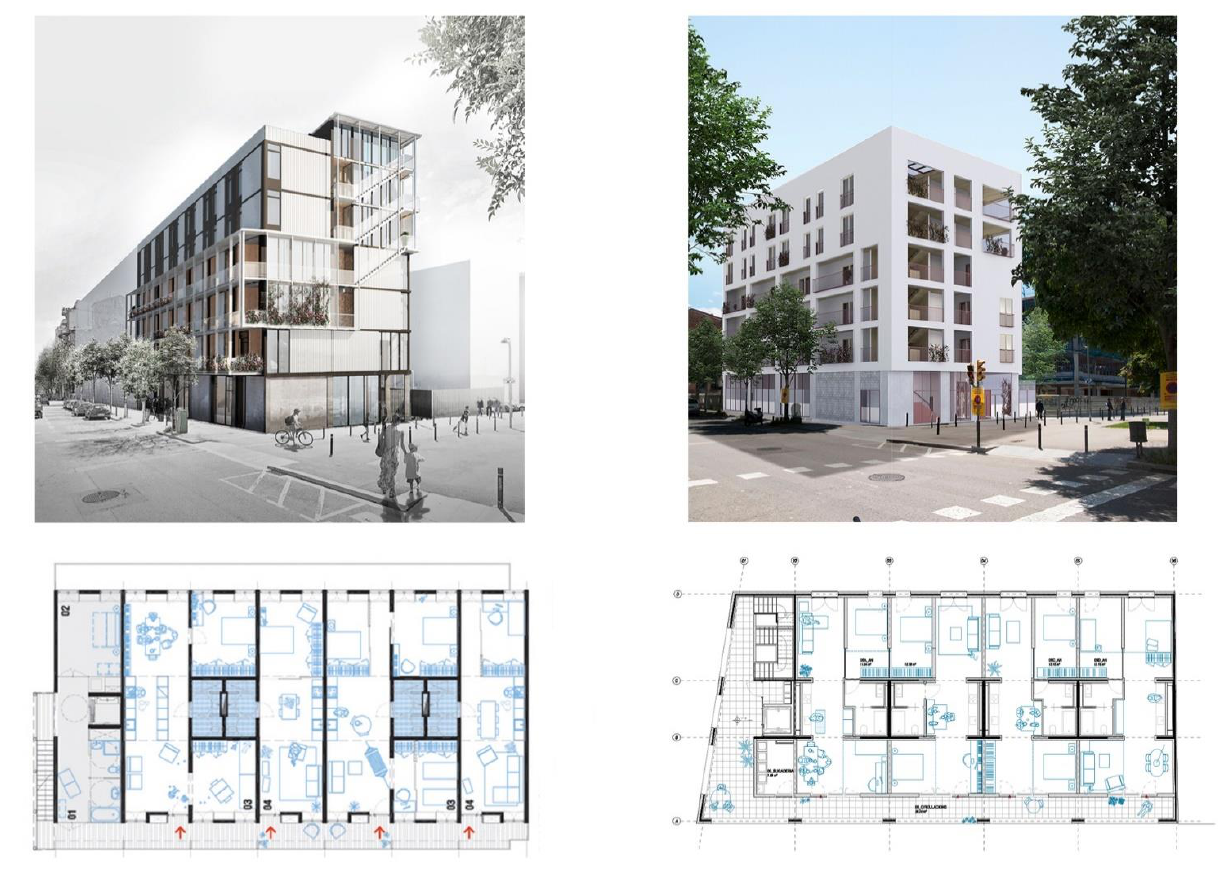
Figure 6. La Balma cooperative housing by Lacol and Laboqueria. Left: Rendering and 4th-floor plan from the competition. Right: Project in the construction tendering phase. Source: Courtesy of Lacol and Laboqueria.